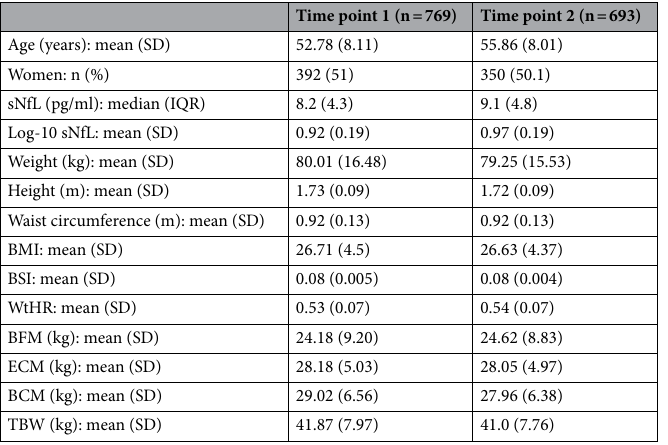
Table 1. Demographic characteristics of the sample. SD standard deviation, sNfL serum neurofilament light, BMI body mass index, BSI body shape index, WtHR waist-to-height ratio, BFM body fat mass, ECM extracellular mass, BCM body cell mass, TBW total body